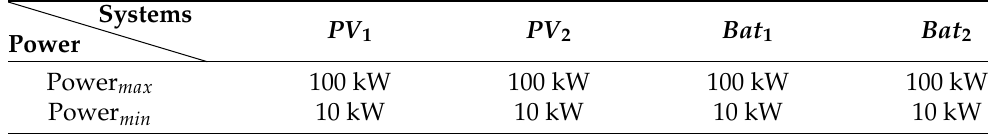
Table 5. Loading condition for four-bus ring-type